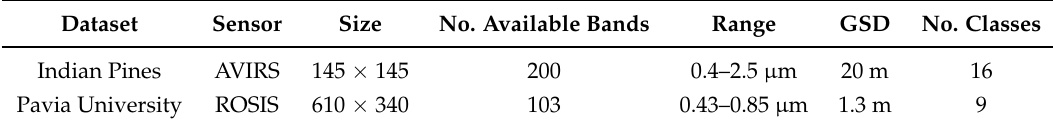
Table 1. Basic information of Indian Pines and Pavia University.